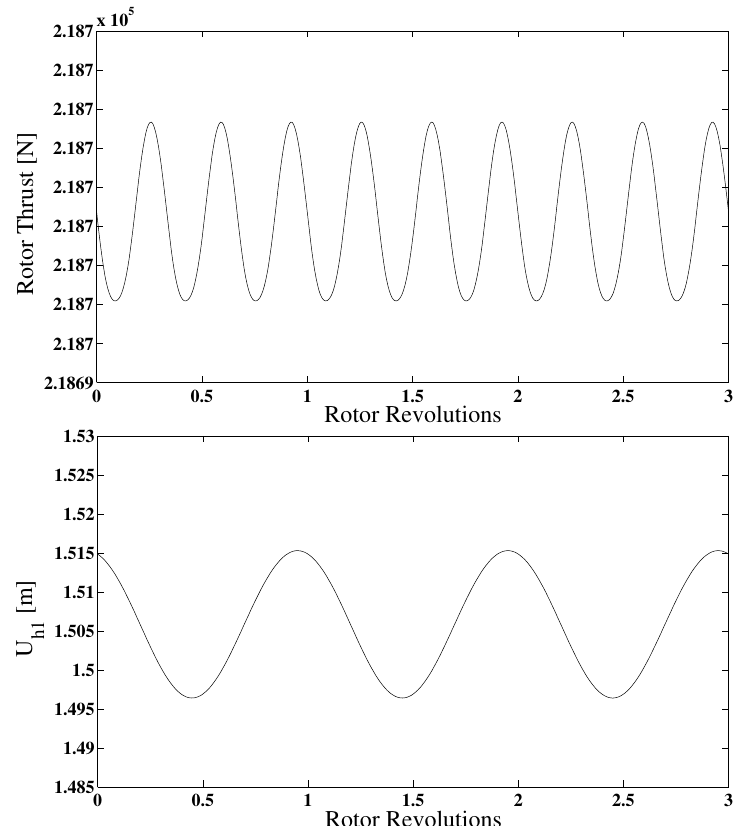
Figure 13. Rotor power, thrust, and displacement of the blade axis, for a section at 90% of the span for an NREL-5MW turbine operating at a typical scenario during its start-up regime, with wind at 6 m/s and rotor speed at 7.9 rpm.